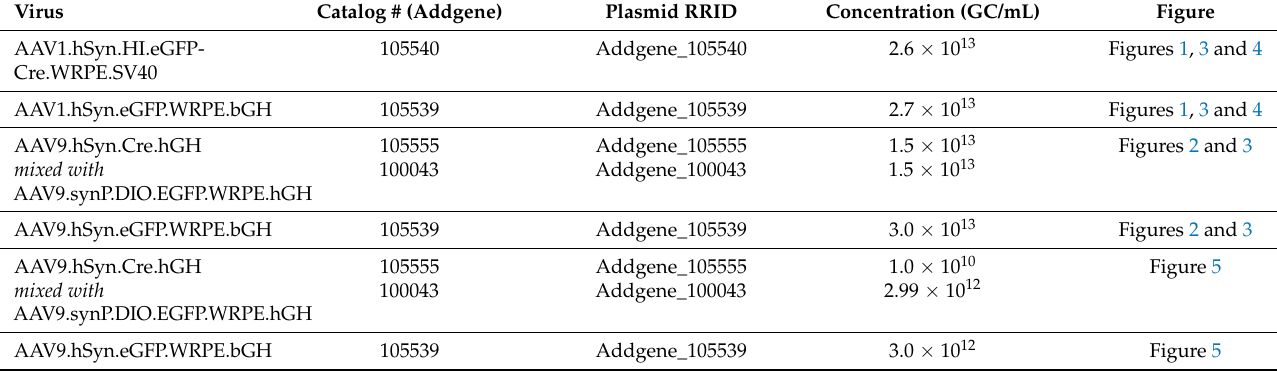
Table 1. AAV constructs used in this study. If applicable, virus titer was adjusted in sterile PBS.